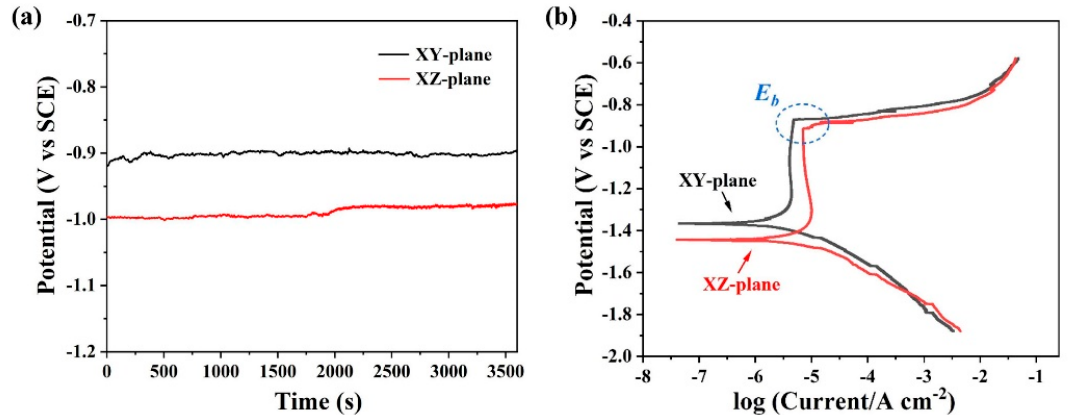
Figure 11. Electrochemical measurement results of samples for different planes in 3.5 wt.% NaCl solution (25 °C): ( a ) OCP curves and ( b ) potentiodynamic polarization curves.